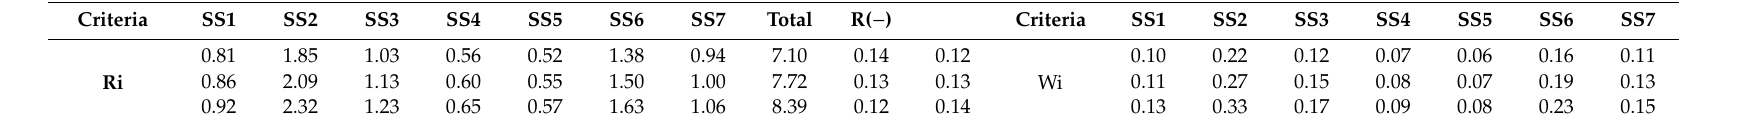
Table 5. Results of the fuzzy weight of all criteria for social